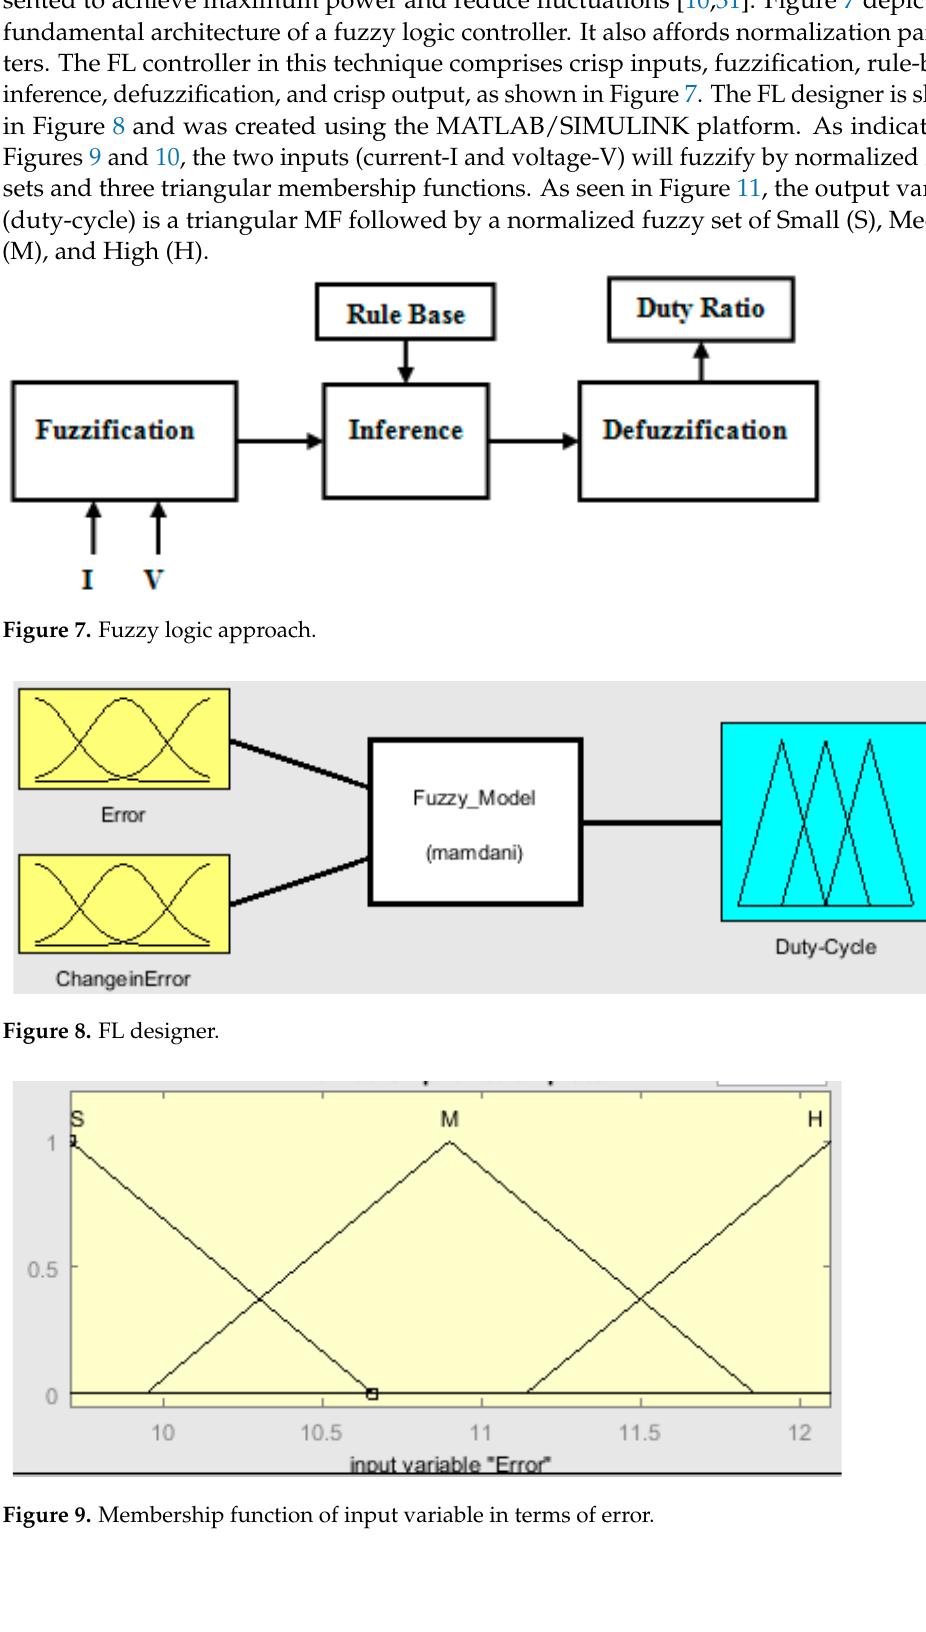
Figure 10. Membership function of input variable in terms of change in error. Figure 11. Membership function of output variable in terms in duty cycle.